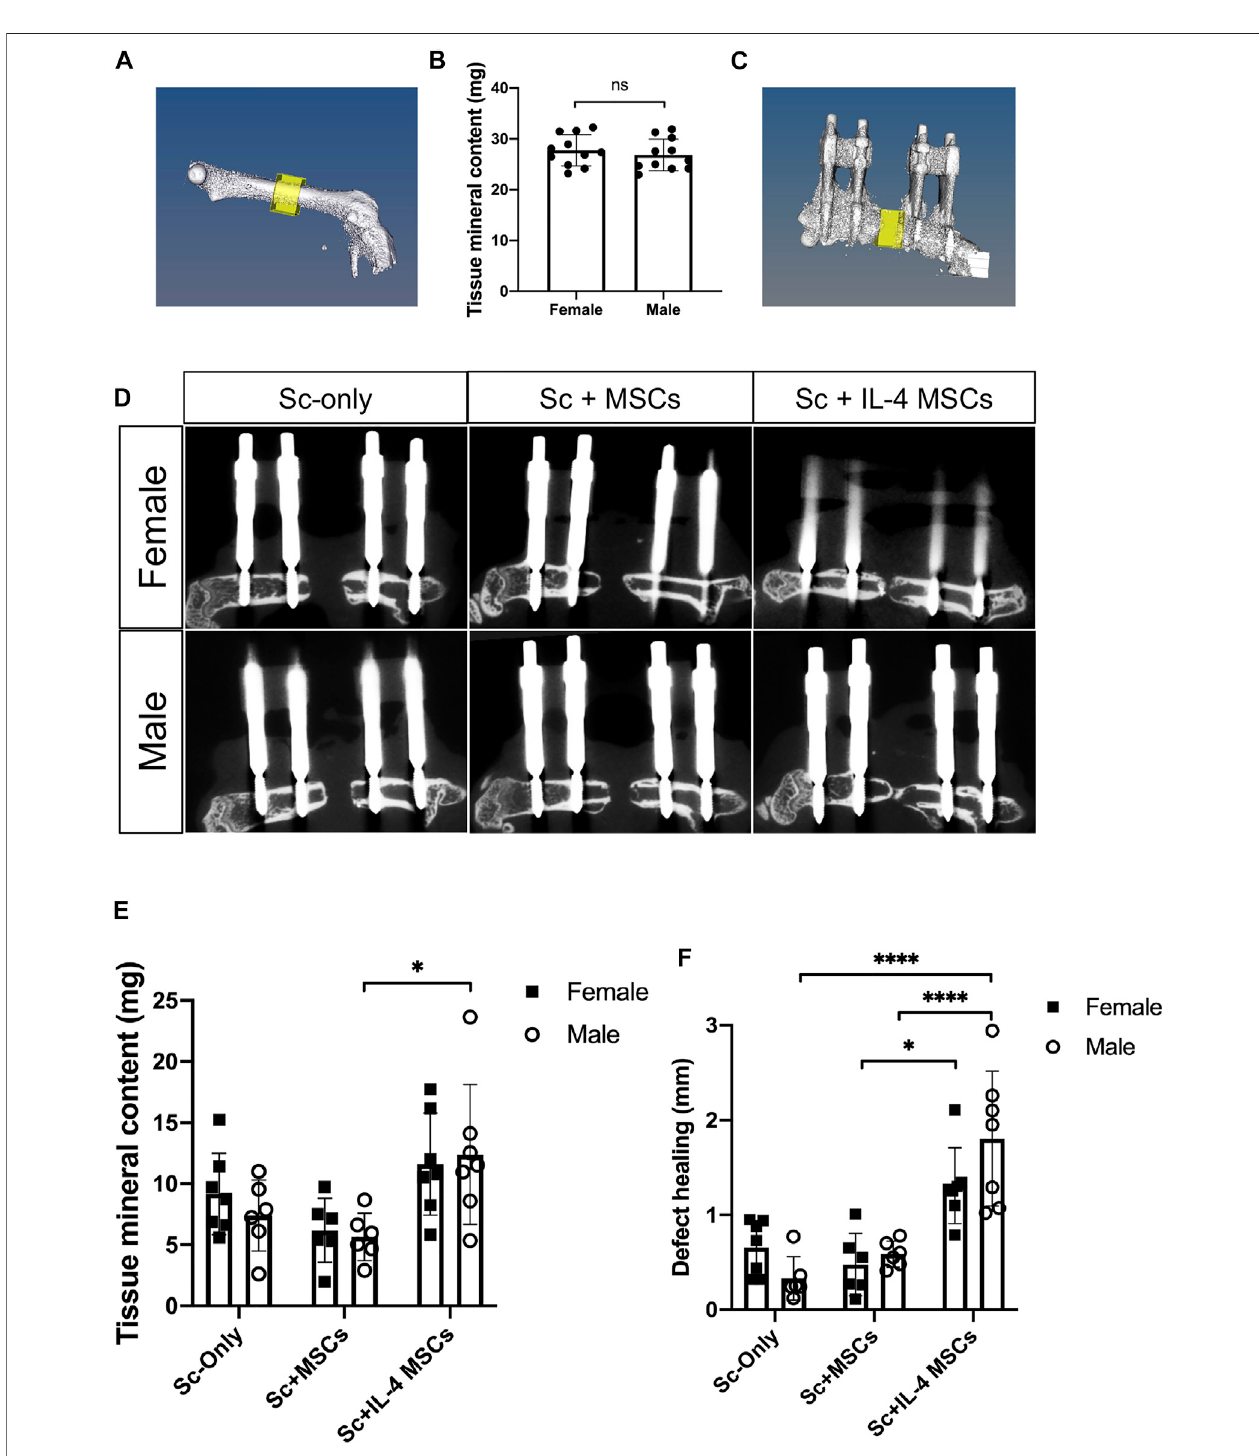
FIGURE 2 | µCT -based reconstructions of the femurs in male and female mice. (A) µCT -based reconstructions of the healthy side of femur and the region of interest. (B) Tissuemineral content(mg) ofthe regionof interest. female, n (cid:2) 16; male, n (cid:2) 16. IL-4MSCsin μ RBs decreased the sizesofbone defects inboth sexes. (C) µCT -based reconstructions of the initial defect area and the region of interest. (D) µCT -based reconstructions of femurs and defect areas of three groups. (E) Tissue mineralcontent(mg)ofthebonedefectareaand (F) defecthealingat6 weeks(mm)calculatedbytheµCT.FemaleSc-only, n (cid:2) 7;femaleSc+MSCs, n (cid:2) 6;female Sc + IL-4 MSCs, n (cid:2) 7; male Sc-only, n (cid:2) 6; male Sc + MSCs, n (cid:2) 6; male Sc + IL-4 MSCs, n (cid:2) 7. *: 0.01 ≤ p < 0.05, ****: p < 0.0001.